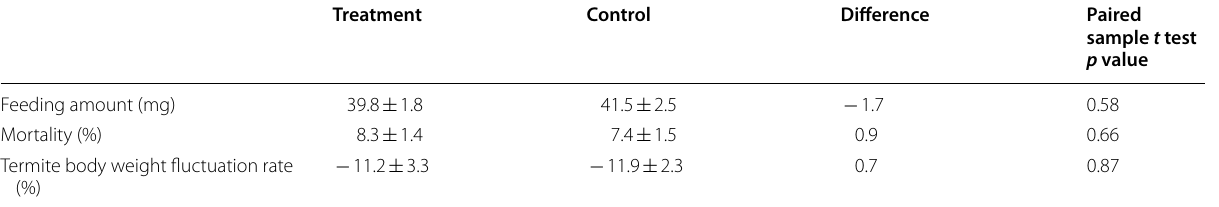
Mean values are shown with standard error. Comparison of filter paper treated with DKP and treated with deionized water (control) is shown